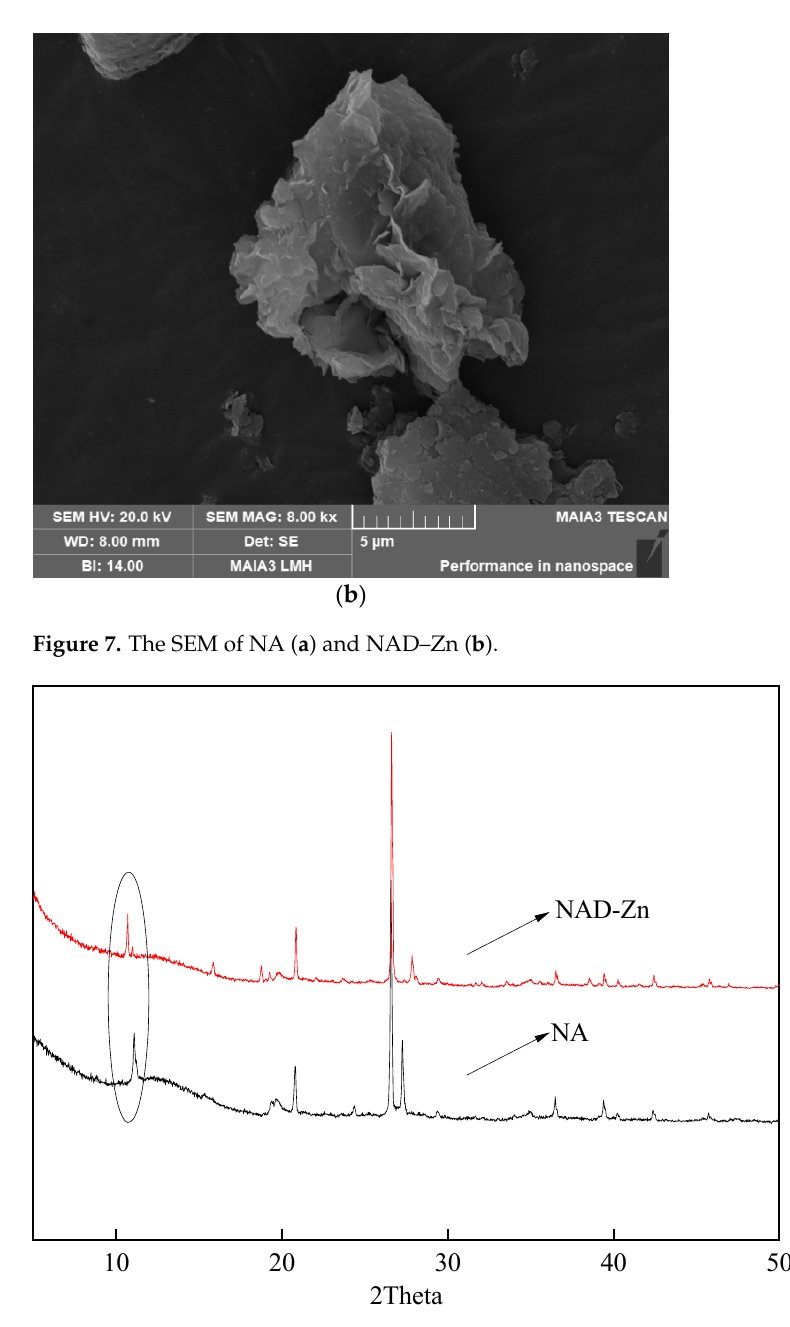
Figure 8. The XRD spectrum of NAD – Zn.